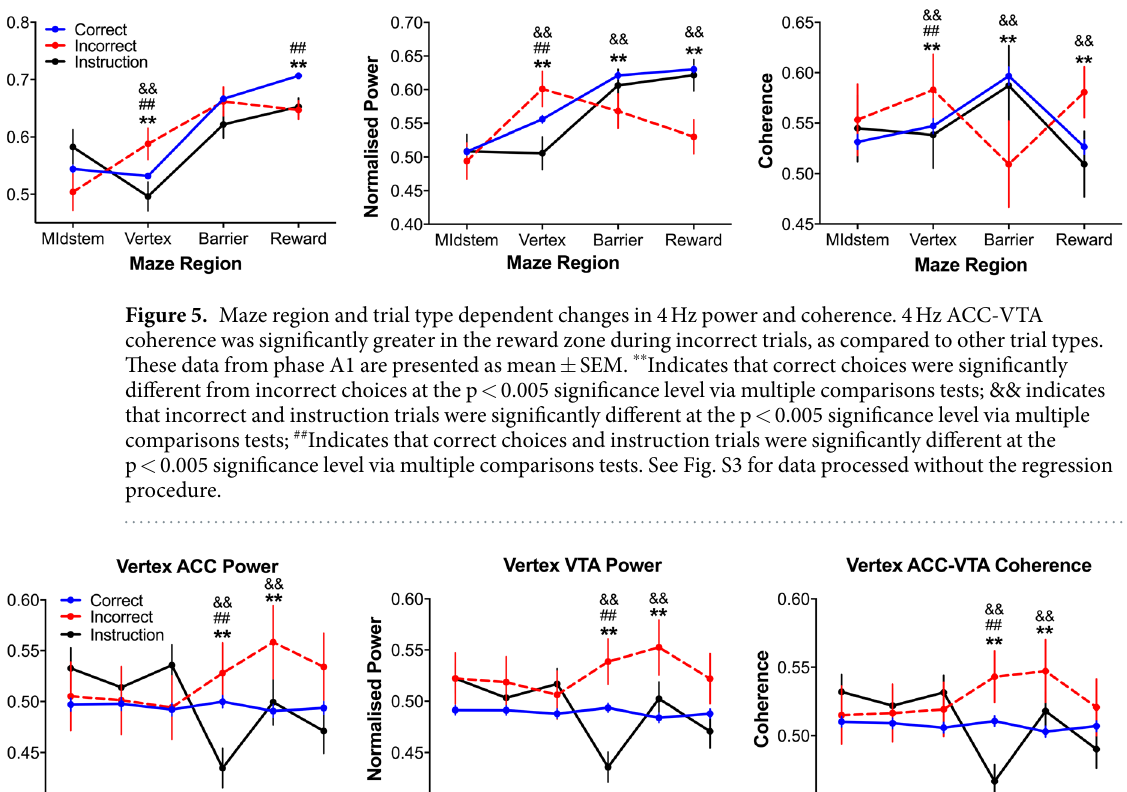
measure, we did not normalise the input data. The between-subject variance was accounted for according to the regression procedure described earlier (see Fig. S5 for analyses without the regression procedure). To ver- ify the integrity of the PDC modelling, we scrambled the recorded signals from both ACC and VTA and con- ducted the trial-by-trial, region-by-region PDC analysis again. In the case of ACC → VTA directionality, the mean of the permutated PDC distribution was not significantly different from the non-permuted data (p > 0.05, t-tests, n = 1000 permutated PDC magnitudes vs 1000 non-permuted residual PDC magnitudes). In the case of VTA → ACC directionality, however, the mean of the permutated PDC distribution was significantly weaker than the non-permuted distribution (p < 0.0005, t-test), indicating that our VTA → ACC PDC results were sig- nificantly different from chance. We therefore focused subsequent analyses on the VTA → ACC PDC models. In a result that was consistent with the 4 Hz coherence findings, VTA → ACC 4 Hz PDC significantly varied by maze region and trial type (Fig. 7a; region main effect: F 3,4047 = 8.75, p < 0.005; trial type main effect: F 2,4047 = 5.40, p < 0.005; trial type x region interaction: F 6,4047 = 4.30, p < 0.005). This was because VTA → ACC PDC model magnitudes were, generally, greatest in the vertex and during incorrect choice trials. Post hoc multiple compar- isons tests (both p < 0.005) confirmed that the interaction was a result of the VTA → ACC signal being signifi- cantly greater in the vertex and reward regions during incorrect choice trials. In another result that was consistent with the changes in vertex coherence, VTA → ACC PDC was greater during incorrect choices than during both correct choices and instruction trials and VTA → ACC PDC was greater during correct choices than during